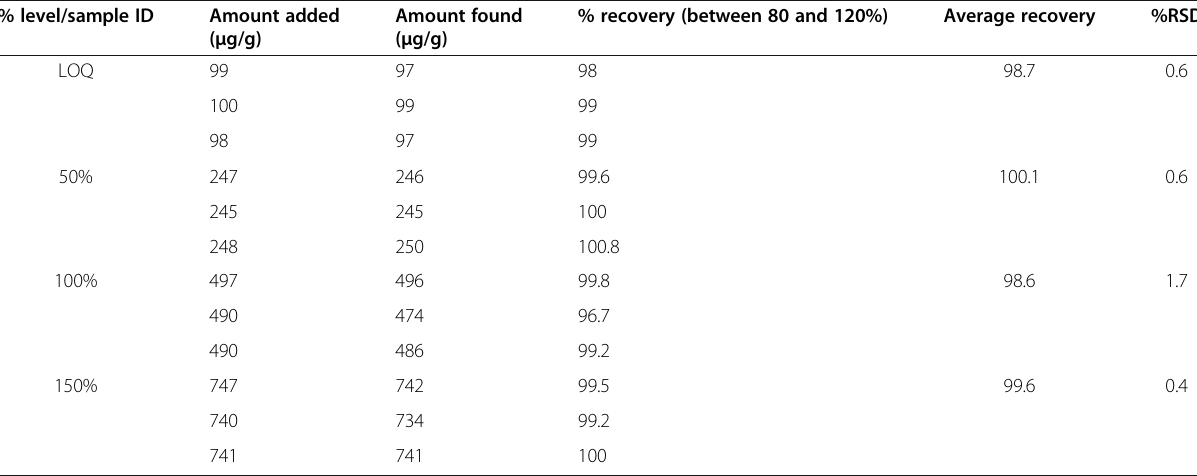
Table 4 Representation of accuracy results LOQ, 50% to 150% level